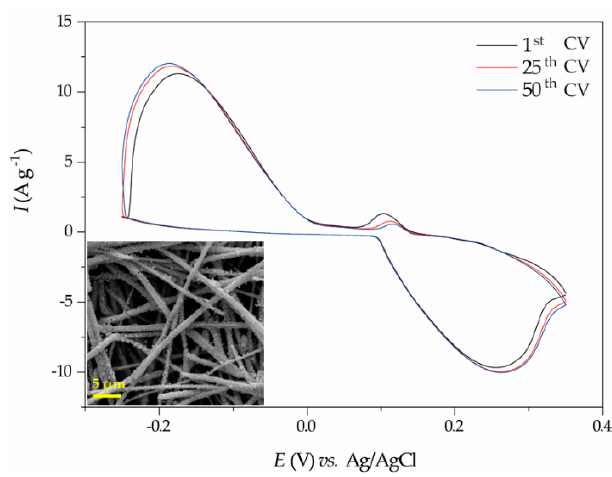
Figure 3. CV plots of scanning cycles of 1, 25, and 50. The inset SEM image exhibits the morphology of Ag NWs after the CV scanning.